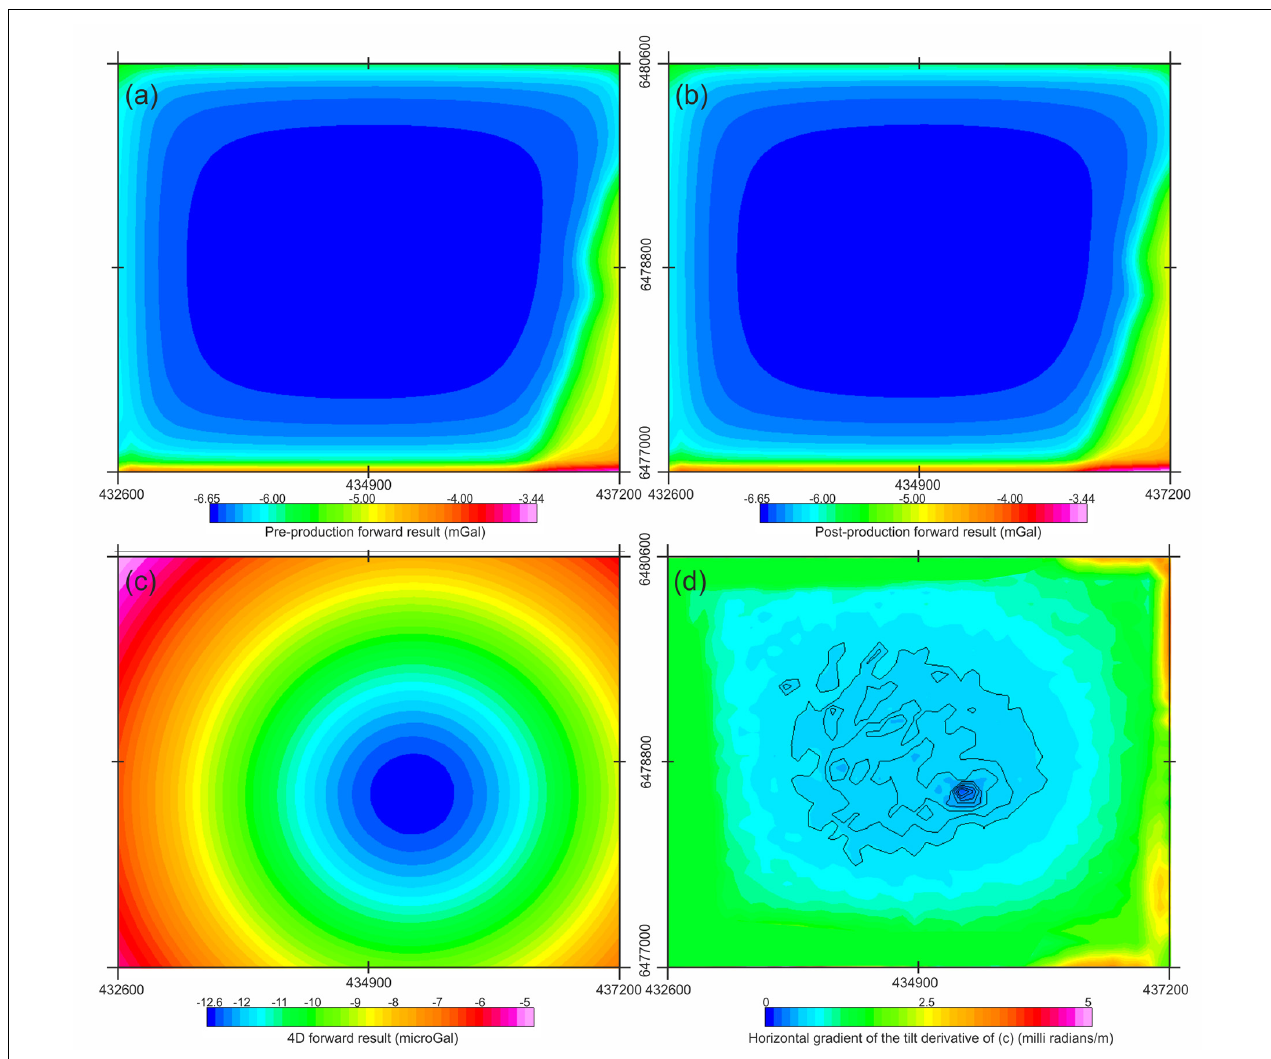
FIGURE 3 | Forward-calculated gravity signature of the pre-production (a) and post-production (b) models. (c) Differential gravity signature calculated by subtraction of pre-production (a) from post-production gravity (b) . Spacing between stations for forward calculations is 50 m. (d) Horizontal gradient of the tilt derivative (THDR) computed from (c) . Contours locate areas with value < 1 milliradians m − 1 .